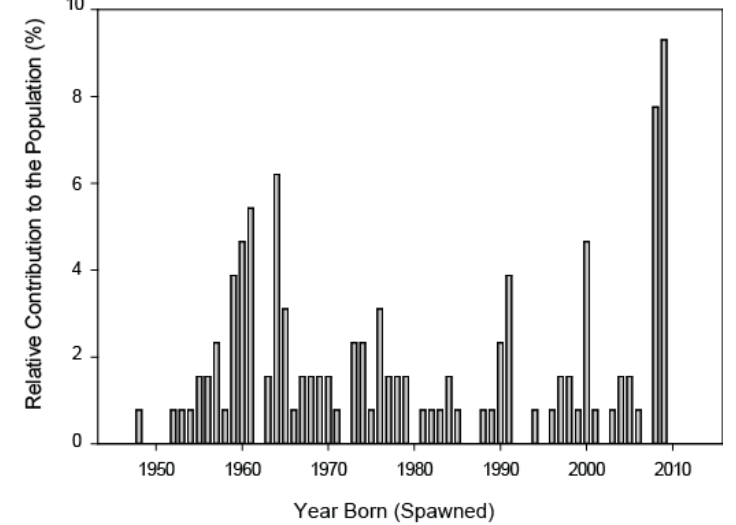
Figure 3. Age structure of adult carp collected from lakes Kohlman, Gervais and Keller. Data from [21] which were re-analyzed for this figure to show their percent contribution to the population. Fish were captured and aged in 2011.